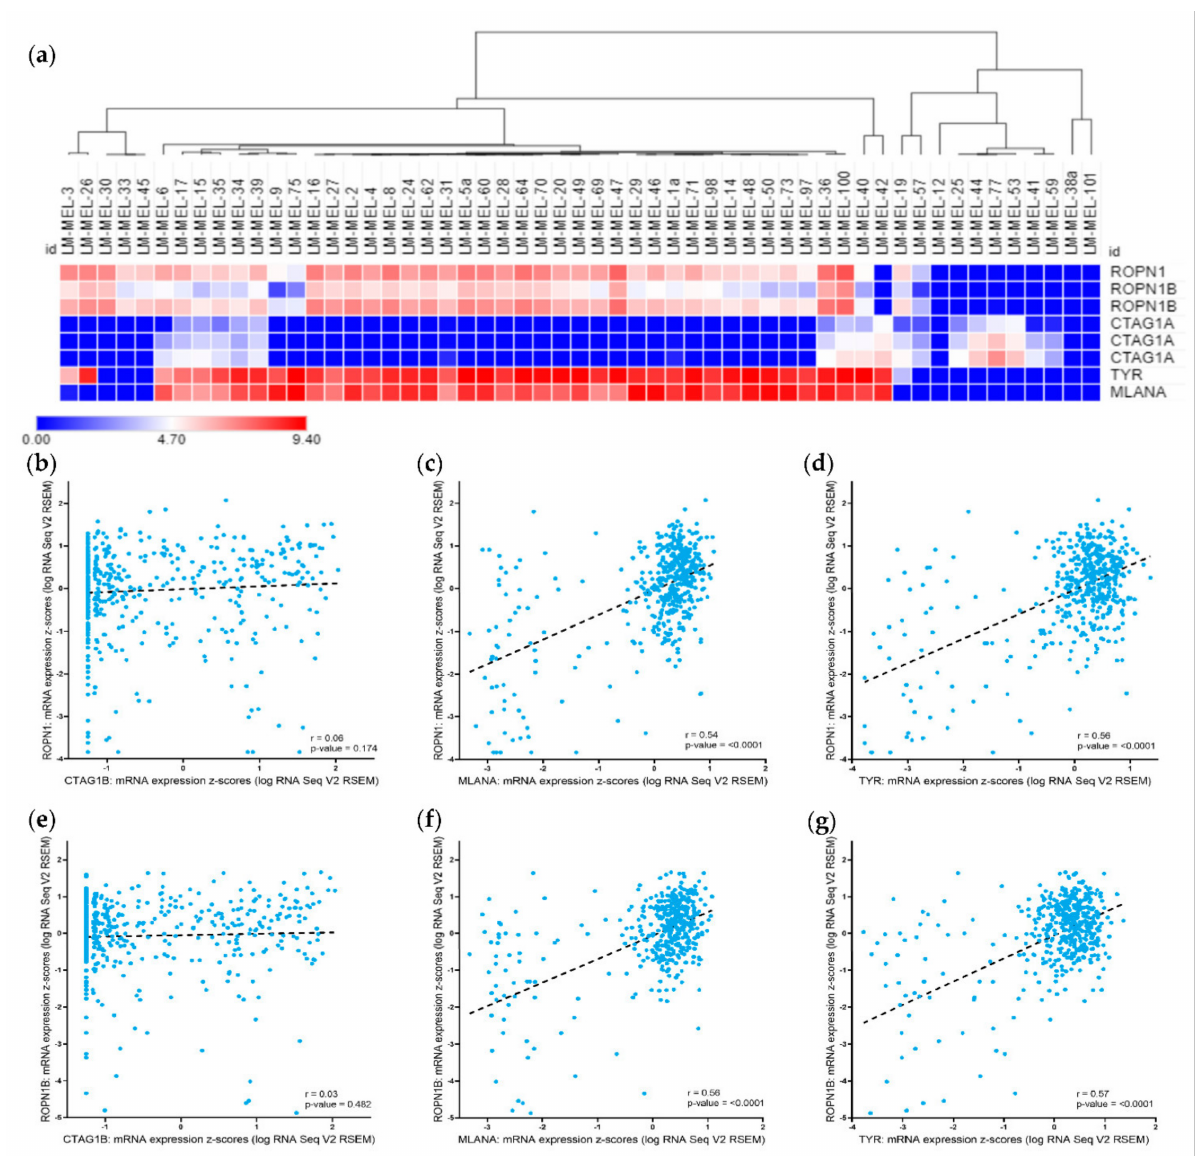
Figure 1. Gene expression of ROPN1, ROPN1B, CTAG1A/B , TYR and MLANA in melanoma cell lines and tumours. ( a ) Heat map representing the hierarchical clustering by Pearson correlation of ROPN1, ROPN1B, CTAG1A, TYR and MLANA gene expression in 55 in-house generated melanoma cell lines derived from 52 patients [32]. Each row shows absolute level of expression results for one specific probe for the respective gene. The full gene expression dataset can be found under GEO dataset ID GSE89438. ( b ) mRNA co-expression plots for ROPN1 and CTAG1B ( r = − 0.06, p -value = 0.174), or ( c ) TYR ( r = 0.56, p -value < 0.0001) or ( d ) MLANA ( r = 0.54, p -value < 0.0001); and ( e ) mRNA co-expression plots for ROPN1B and CTAG1B ( r = 0.03, p -value = 0.482), or ( f ) TYR ( r = 0.57, p -value < 0.0001) or ( g ) MLANA ( r = 0.56, p -value < 0.0001) in 472 TCGA melanoma patient samples (469 patients). mRNA expression is shown as z-scores relative to all samples (log RNA Seq V2 RSEM), and correlation is analysed using the Pearson correlation. Gene Expression Omnibus, GEO; TCGA, The Cancer Genome